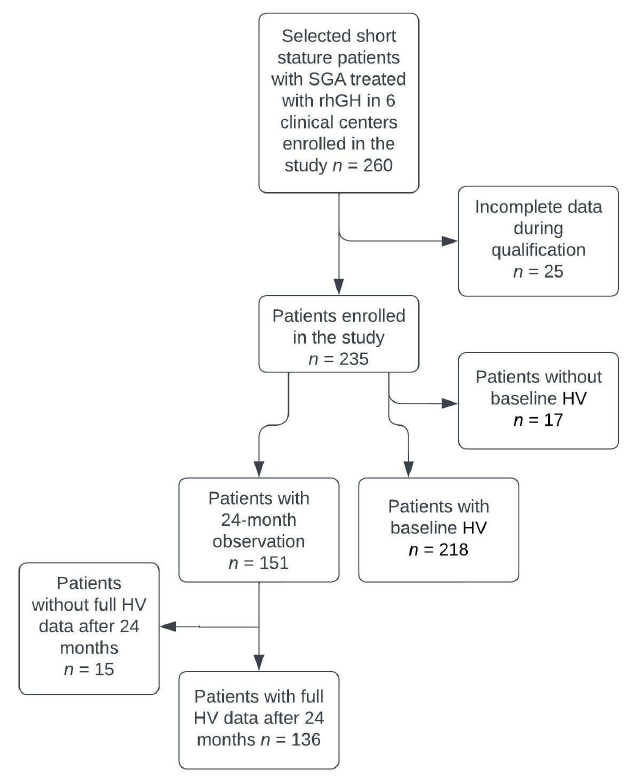
Figure 1. Data collection process. SGA: short for gestational age; rhGH: recombinant human growth hormone; HV: height velocity.